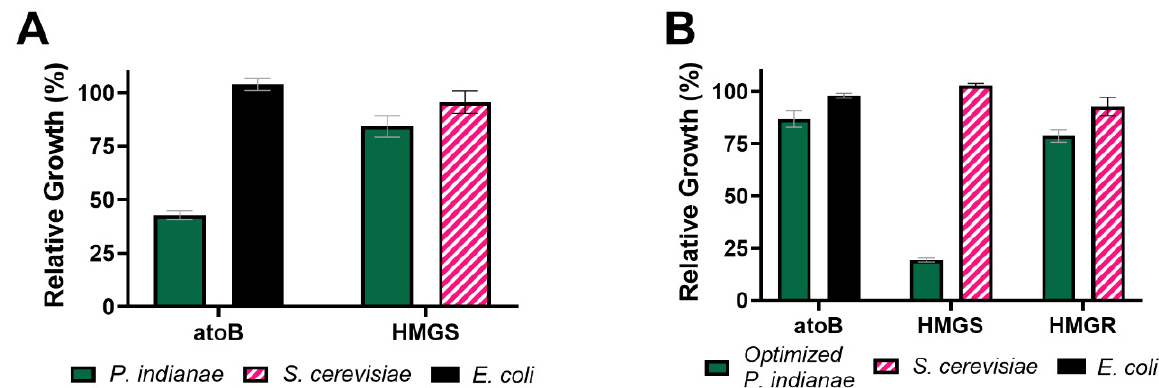
Figure 5. Relative growth in additional strains or with optimized genes. ( A ) Relative growth of E.coli BL21 + RIPL expressing the E. coli , S. cerevisiae , or P. indianae homologs of the mevalonate pathway. ( B ) Relative growth of E. coli BL21 expressing the E. coli -codon optimized versions of the P. indianae genes compared to the respective atoB , HMGS , or HMGR homolog. Relative growth is calculated by taking the final OD 600 of the induced gene divided by the final OD 600 of the uninduced gene. Error bars represent standard deviation; n = 3 for all conditions.